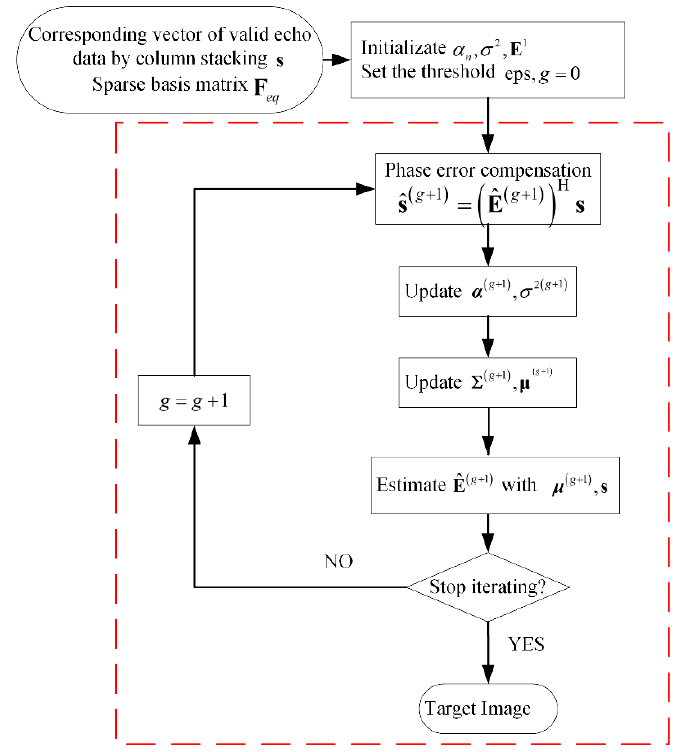
Figure 3. Flow chart of the reconstruction algorithm.